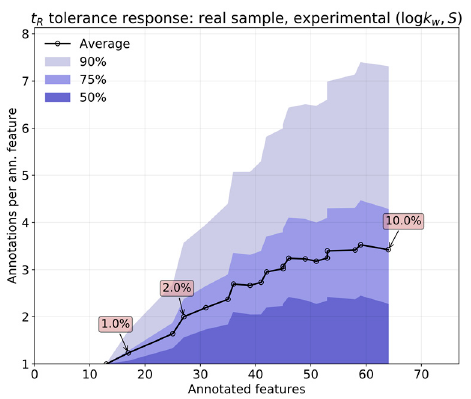
Figure 6. Annotation multiplicity (Exp).